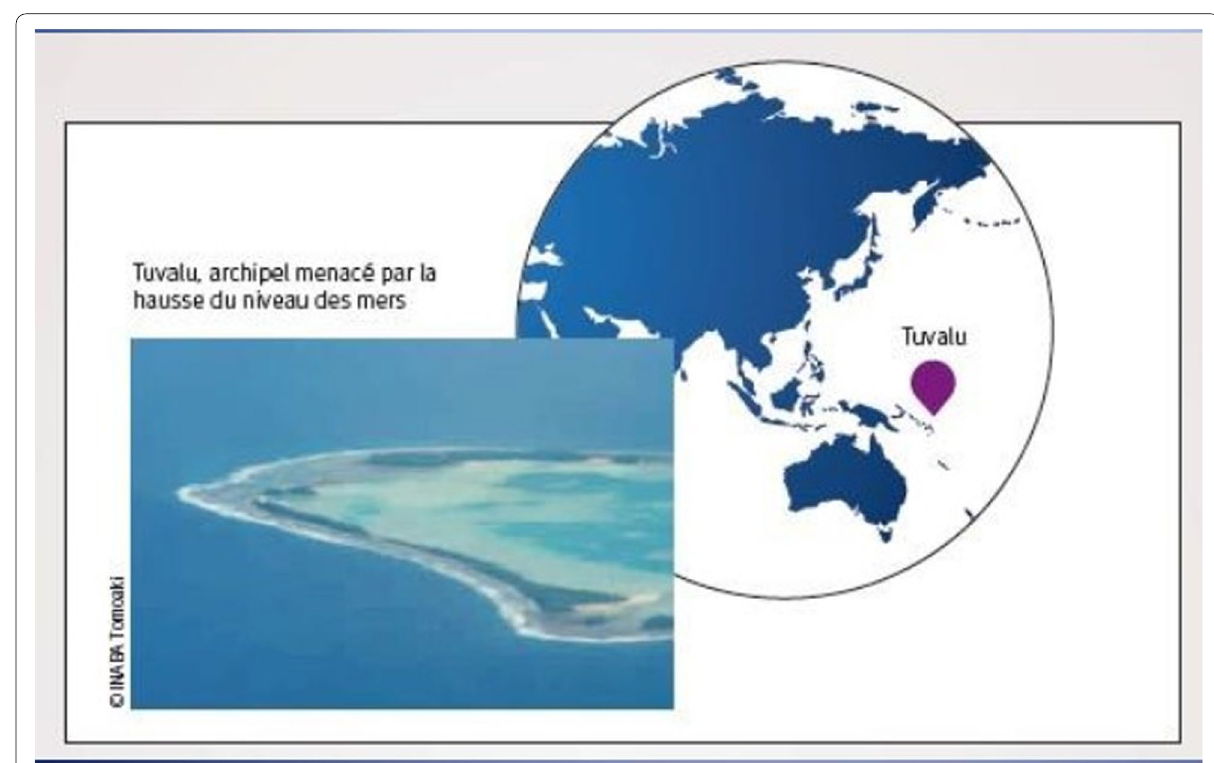
Fig. 5 Representative slide from student presentation about Population Migrations and climate change. Source: Kit pédagogique le changement climatique p30. https:// resea uacti oncli mat. org/ publi catio ns/ kit- pedag ogique- chang ements- clima tiques/ (Publisher gives permission to use these in public education.)